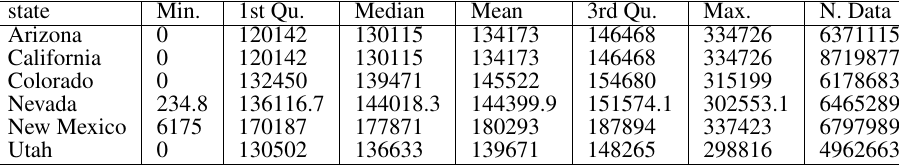
Table 3. Solar Direct Radiation in Winter.